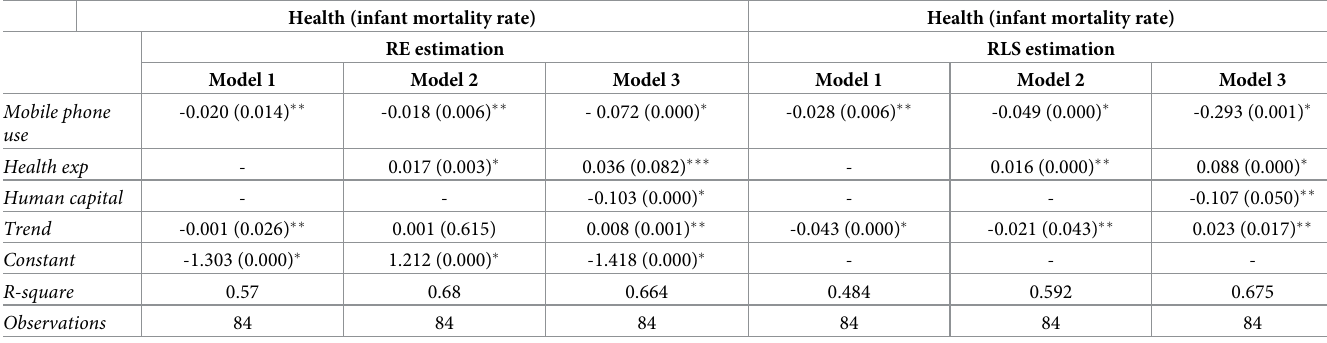
Table 5. Results of ICT and health (infant mortality